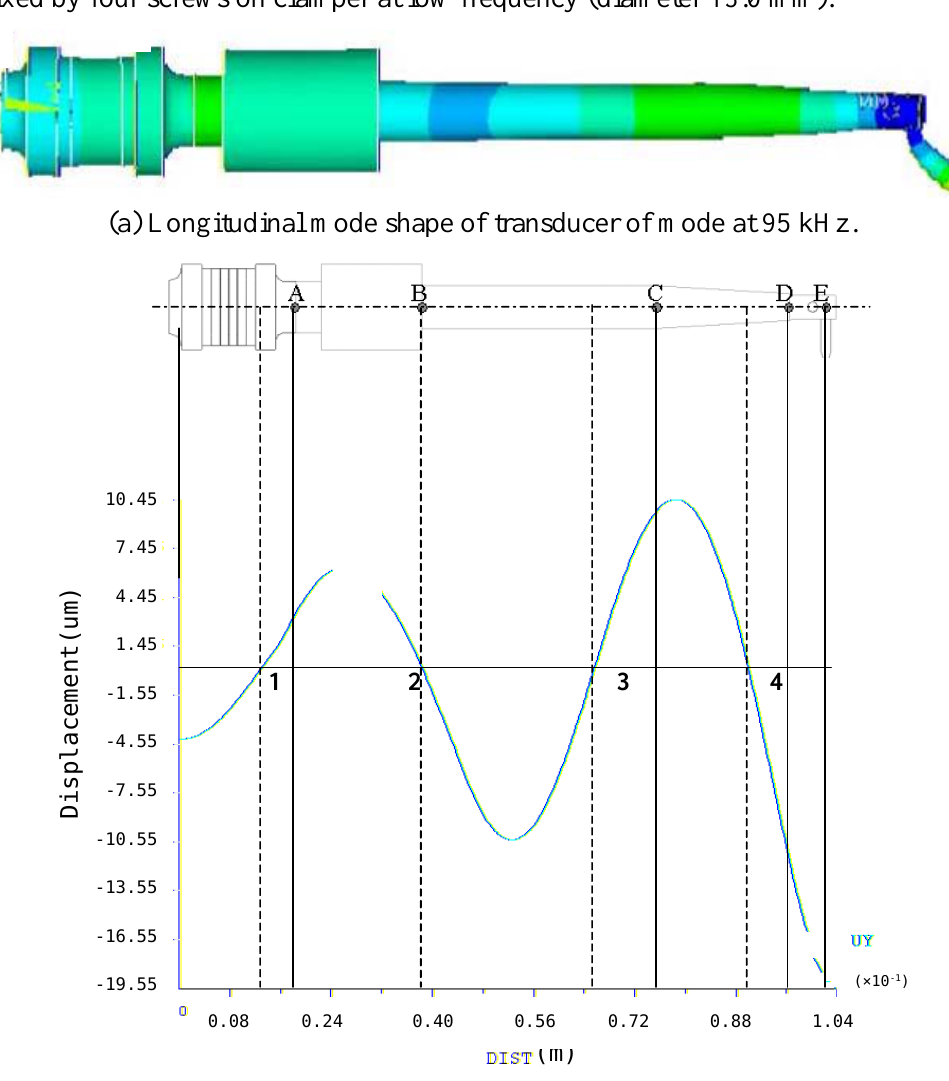
Figure 10. Useful longitutinal mode of transducer with horn holder completely clamped and fixed by four screws on clamper at low frequency (diameter 13.0 mm).